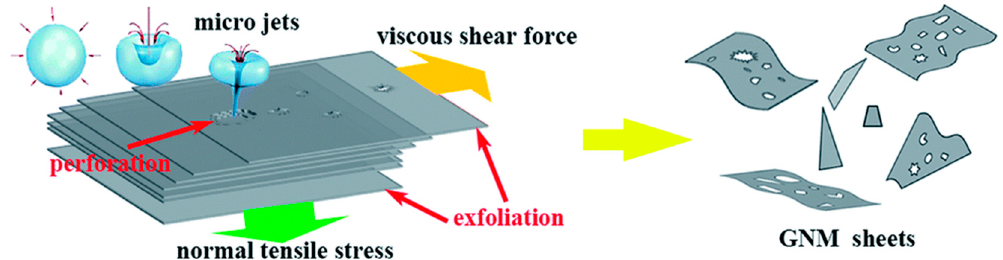
Figure 14. A schematic illustration showing the exfoliation mechanism of the jet cavitation. Reproduced from [74]. Copyright Royal Society of Chemistry, 2014.